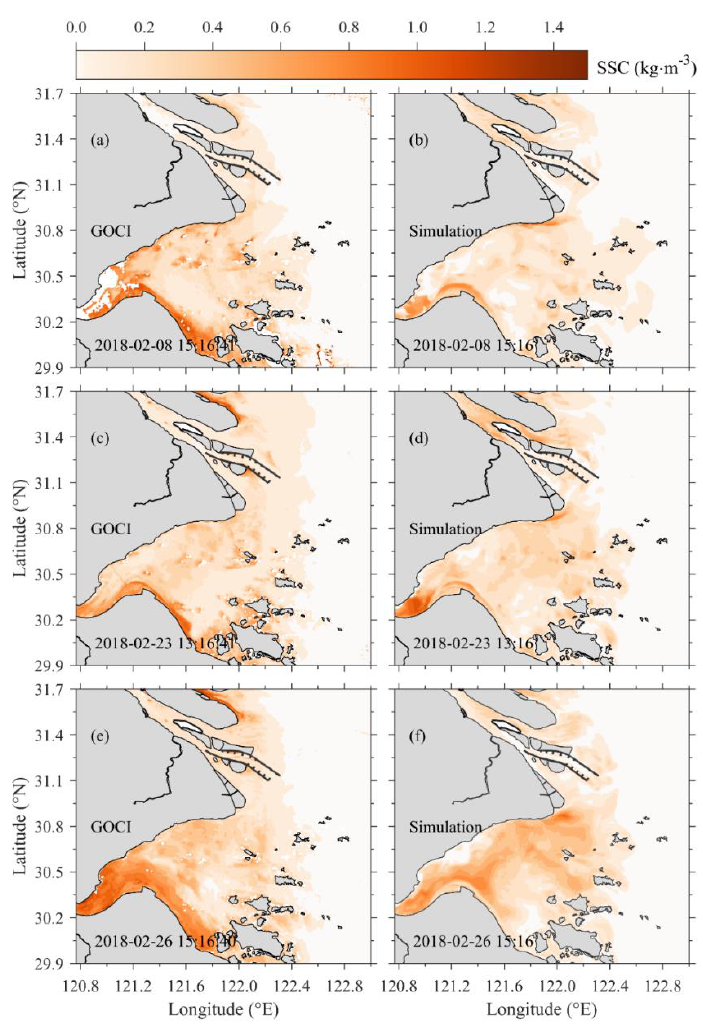
Figure 6. Comparison of the satellite inversion of SSC with simulated surface SSC fields at 15:16, 08 February 2018, 13:16, 23 February 2018 and 15:16, 26 February 2018. Surface SSC derived from GOCI satellite data ( a , c , e ); surface SSC simulated by the model ( b , d , f ).